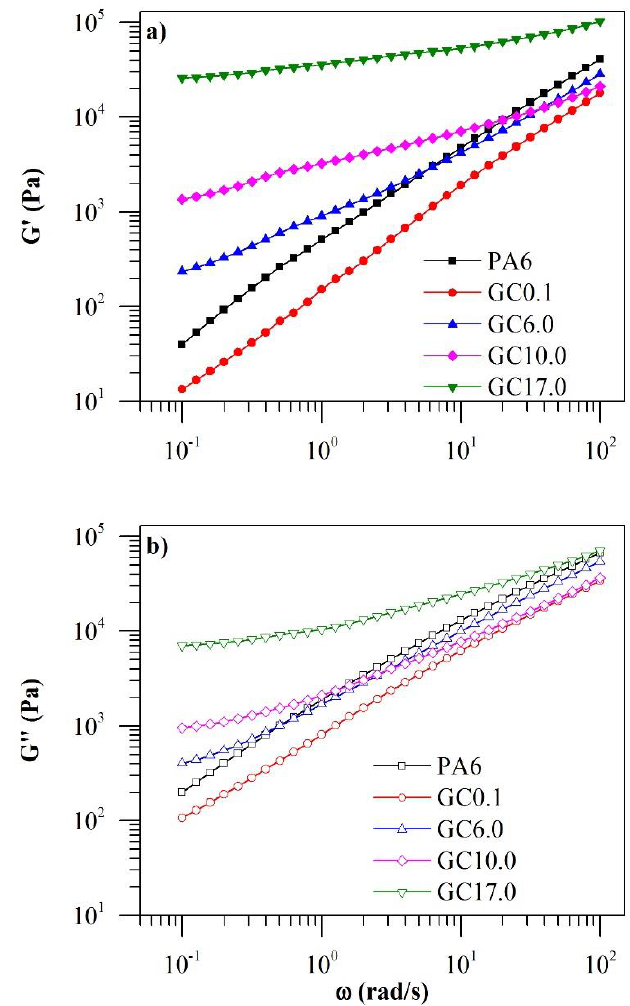
Figure 2. Change in ( a ) G’ and ( b ) G” of neat PA6 and GC with a change in ω at 245 °C.